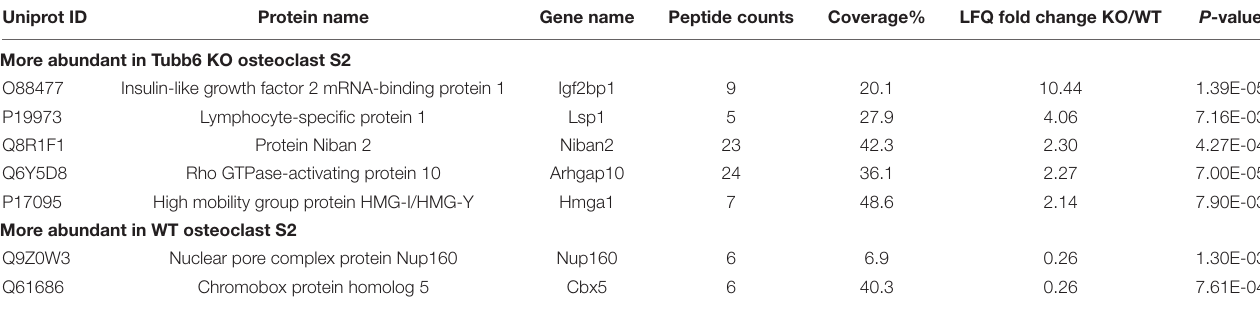
TABLE 1 | Protein changes in fractions